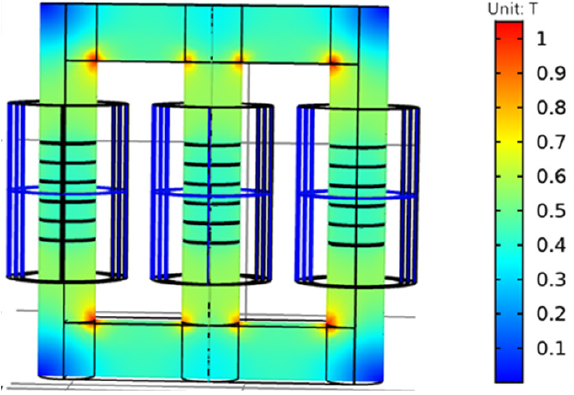
Figure 2. Magnetic flux density distribution chart.